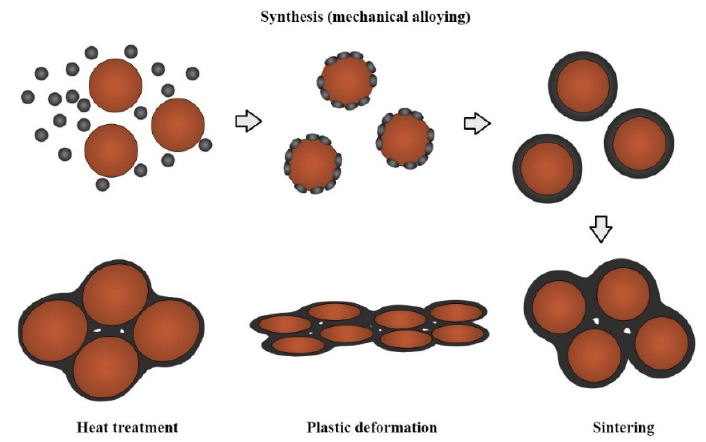
Figure 7. Microstructure transformation induced by following technological steps: mechanical alloying, heat treatment, plastic deformation and sintering.